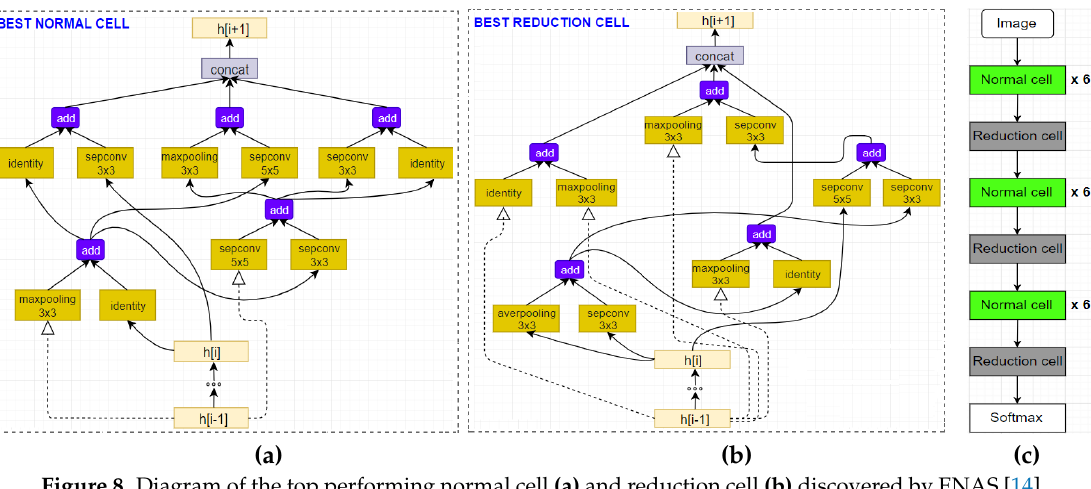
Figure 8. Diagram of the top performing normal cell (a) and reduction cell (b) discovered by ENAS